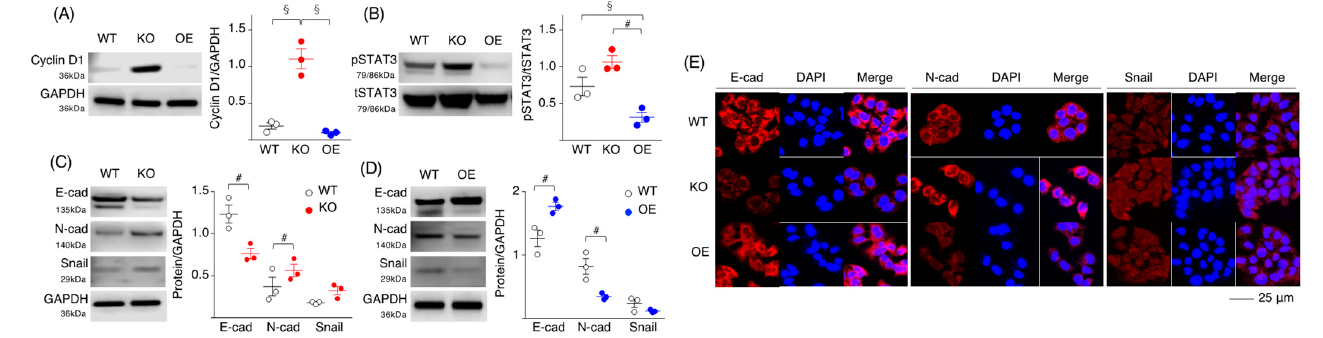
Figure 2. SPRED2 controls molecular expression related to cancer growth and progression. ( A – D ) Cell lysates were prepared from WT, SPRED2-KO and SPRED2-OE cells, and the presence of each protein was evaluated by western blotting. Band densities were digitized and semi-quantitated ( n = 3, each). ( E ) Cells were seeded on Lab-Tek II Slide, fixed in acetone and immunostained with the indicated primary antibodies. Representative photos are shown. # p < 0.05, § p < 0.01, two-tailed unpaired t test.